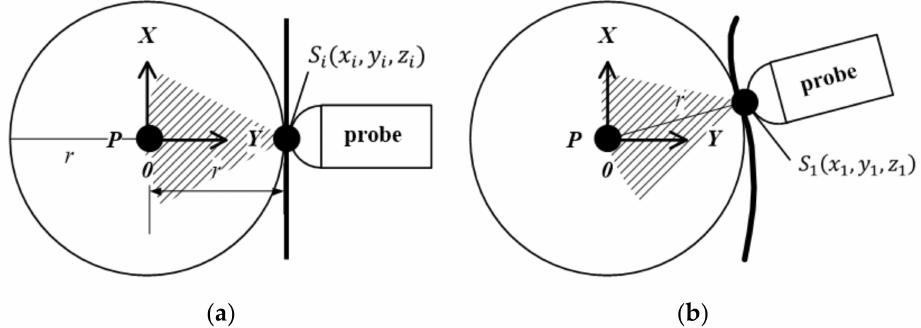
Figure 3. Method based on Hough transform: ( a ) Target surface unchanged; ( b ) Target surface change.